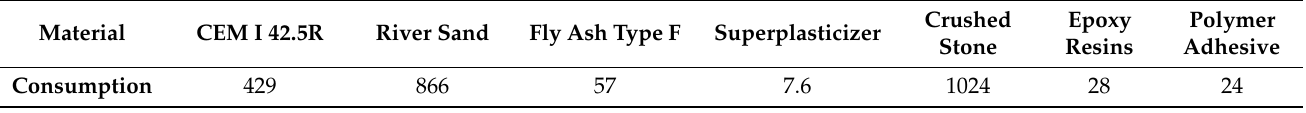
Table 1. Mixture proportions of mortar (Unit: kg).